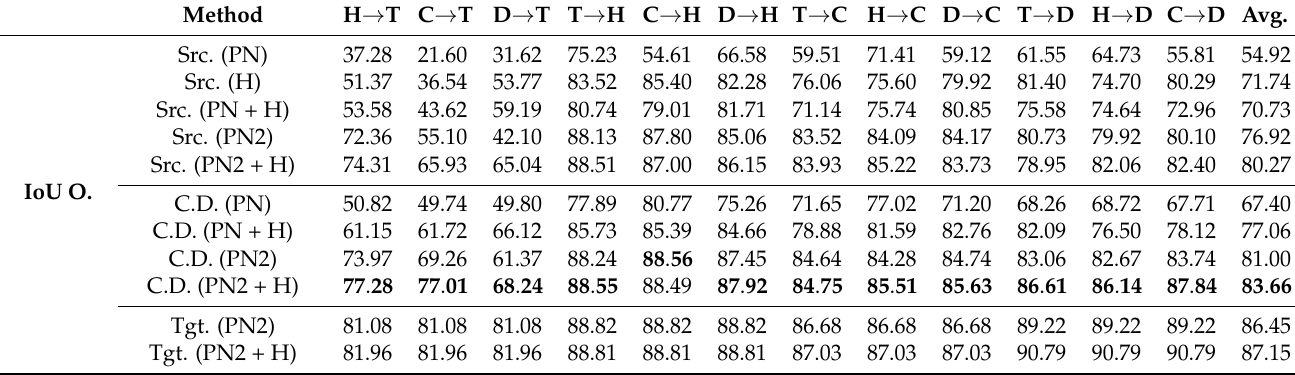
Table A1. The overall IoU (IoU O.) and average IoU over height segments (IoU Seg.) of the point cloud semantic segmentation methods under each of the 12 cross-dataset scenarios. We compare our cross-dataset semantic segmentation methods (denoted as C.D. ) with the supervised baselines trained only on the labelled source training set (denoted as Src. ) and the supervised baselines trained only on the labelled target training set (denoted as Tgt. ). Both Src. and Tgt. baselines are evaluated on the target validation set. We report the average results over the three different training and validation splits for each cross-dataset scenario and we highlight the best result across different methods on each dataset (in bold). The Tumut, HQP, ct03, and DogPark datasets are denoted as T , H , C , and D ,